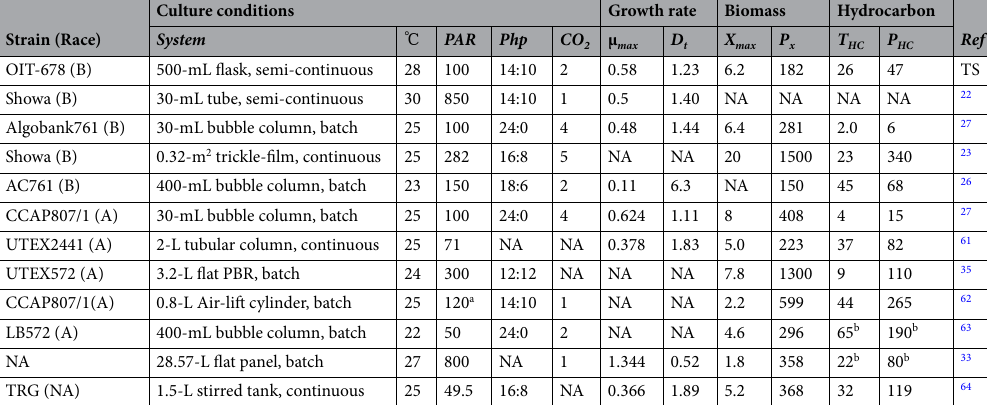
Table 4. Record-holders for the fastest growth rate and highest productivity of biomass and hydrocarbons in Botycococcus braunii . ℃ , temperature; PAR , photosynthetic active radiation (μmols of photons m −2 s −1 ); Php , photoperiod (light:dark hours); CO 2 , % v/v; μ max , specific cell growth rate (d −1 ); D t , doubling time (d); X max , maximum biomass concentration (g L −1 ); P x , biomass productivity (mg L −1 d −1 ); T HC , total hydrocarbons (% dry weight); P HC , hydrocarbon productivity (mg L −1 d −1 ); NA , no information available; TS , this study. a Estimated from the value of 26 W m −2 of a cold-white fluorescent tube. b Values of total lipids instead of